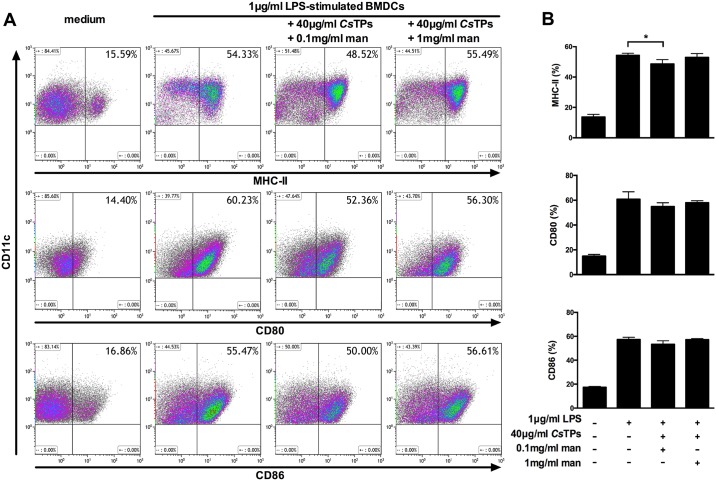
Effects of mannan as an inhibitor of MR on expression of surface markers of BMDCs.(A) Representative images of FACS. 1 × 106/ml LPS-treated BMDCs were pre-incubated with 0.1 mg/ml or 1 mg/ml mannan for 30 min prior to addition of 40 μg/ml CsTPs for 24 h. The expression levels of maturation markers MHC-II, CD80 and CD86 on CD11c+ BMDCs were assessed. (B) Statistical analysis of the expression percentages of surface markers on BMDCs. Data are shown as mean ± SD of three independent experiments. Statistical significance was analyzed by one-sided paired Student’s t-test (*, P < 0.05 vs. LPS group).